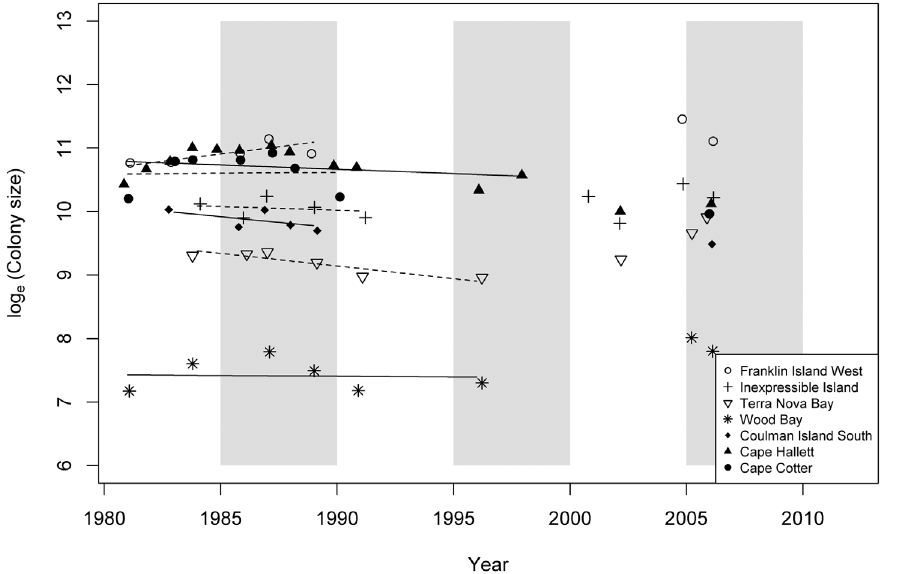
Figure 3. Time series plots of the logged Ade´lie penguin breeding pair counts from colonies that were surveyed more than five times between the years 1981 and 2012 along the Victoria Land coast, Antarctica. The linear regression trend lines are for the period 1981–2000 (in accord with Fig. 2), after which counts became too infrequent to fit a regression.